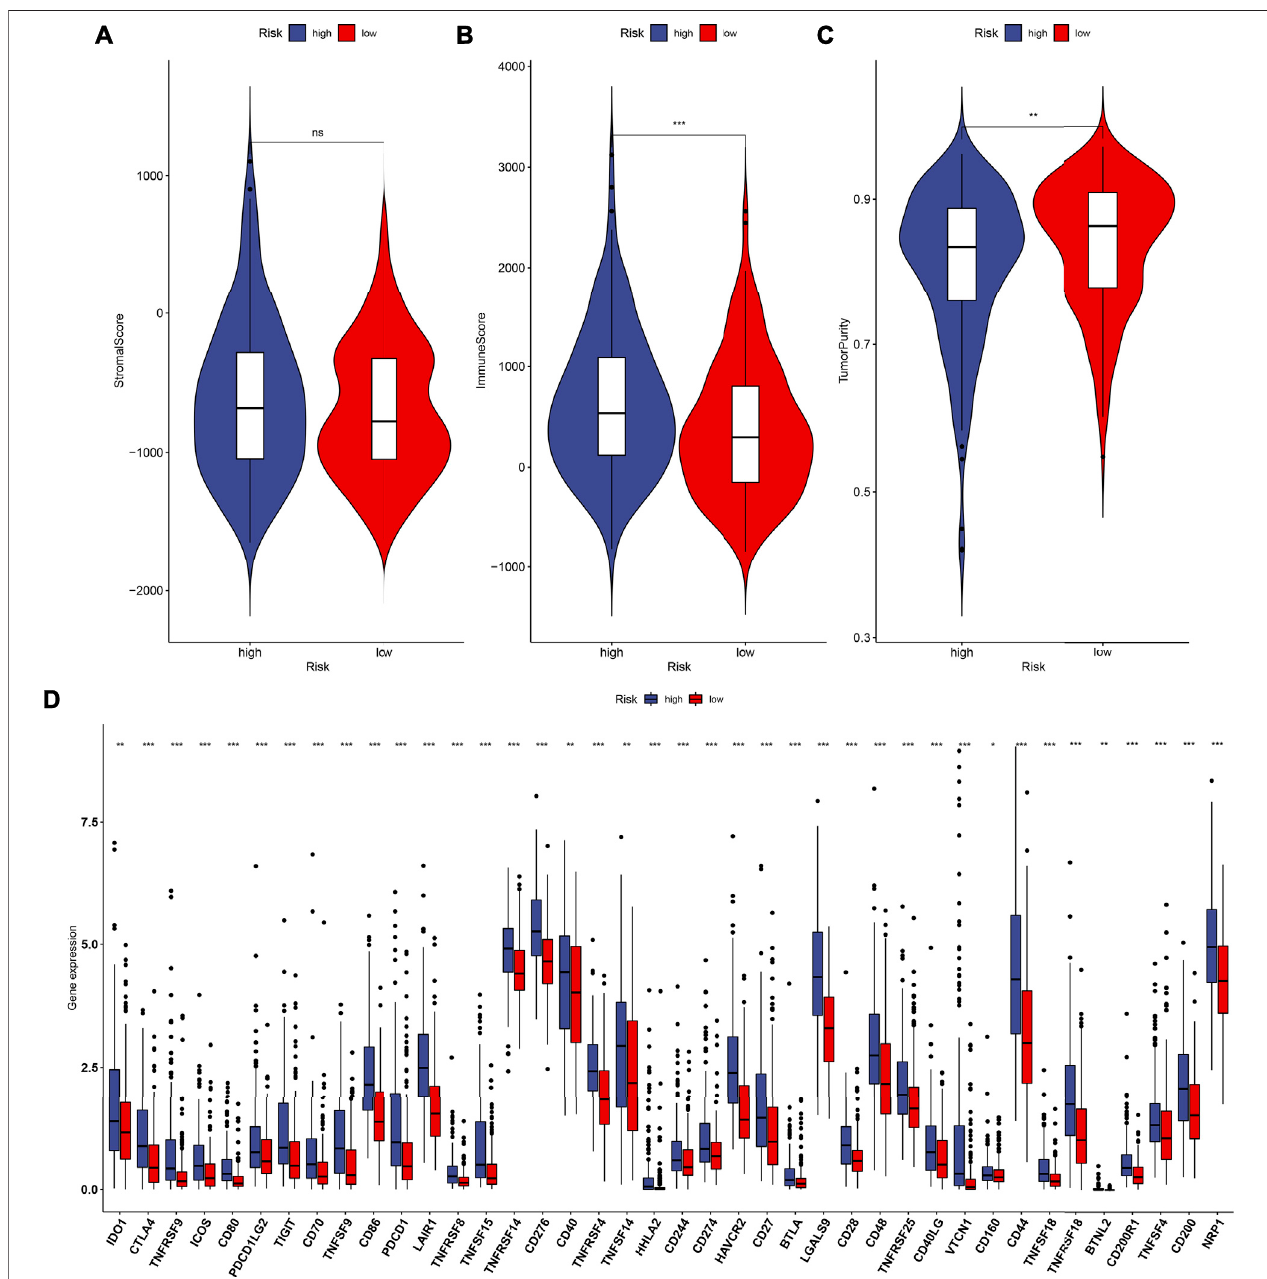
FIGURE6| Estimation ofthe associationsbetween theTLR-based signatureand TMEofHCC in the TCGA cohort. (A – C) Comparisons ofstromal score, immune score, and tumor purity between high and low TLR-based RS groups using the ESTIMATE method. (D) Comparisons of immune checkpoints between high and low TLR-based RS groups. p values were estimated with Wilcoxon rank-sum tests. * p < 0.05; ** p < 0.01; *** p < 0.001; ns: not signi fi cant.